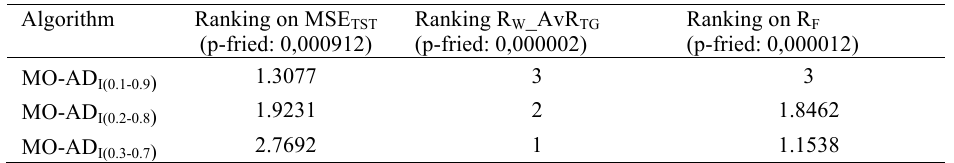
Table A.4 Rankings obtained through Friedman’s test for different values of thresholds on MSE TST , R W _AvR TG and #R F measures using FS_MOGUL rule bases for MAX INT point.